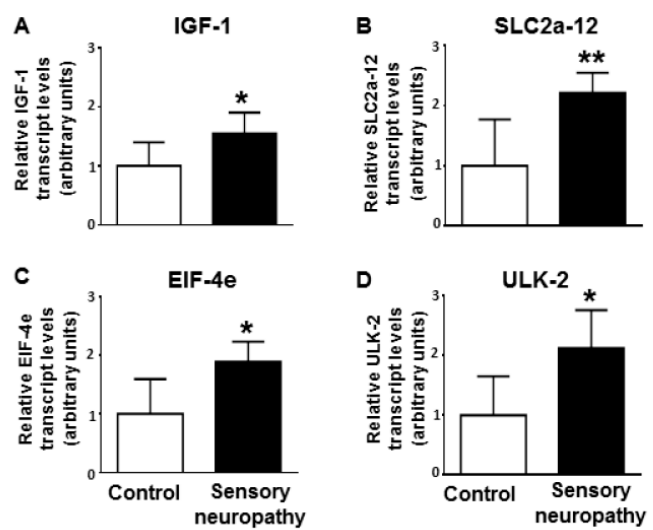
Figure 2. mRNA levels of ( A ) IGF-1 (insulin-like growth factor 1), ( B ) SLC2a-12 (solute carrier family 2 facilitated glucose transporter member 12), ( C ) EIF-4e (eukaryotic translation initiation factor 4e), and ( D ) ULK-2 (Unc-51 like autophagy activating kinase 2) in sensory neuropathic rat heart samples as compared to vehicle-treated controls (control). The transcript levels were normalized to GAPDH (glyceraldehyde-3-phosphate dehydrogenase). Data are expressed in arbitrary units as means ± SD. (n = 5–6, * p < 0.05, ** p < 0.01 versus control; unpaired Student’s t ‐ test).